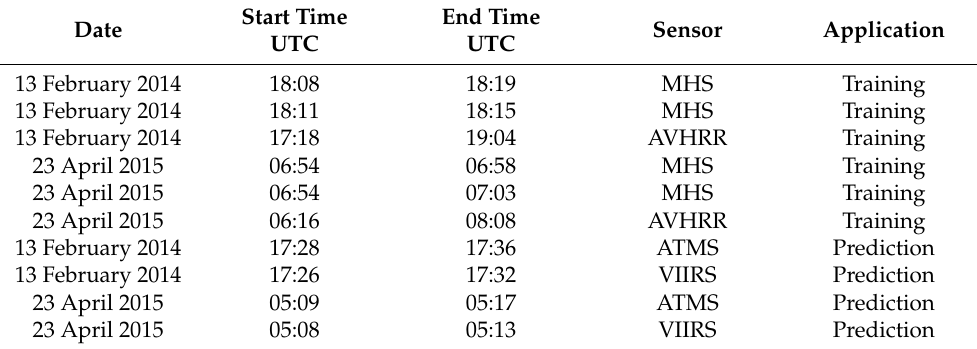
Table 1. Data used for training and prediction